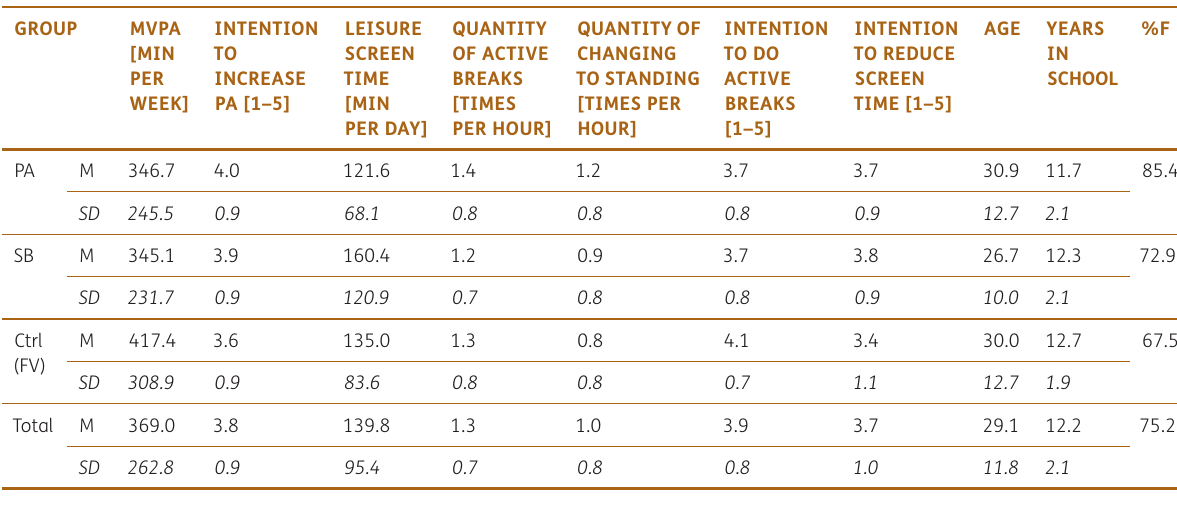
Table 1 Pre-test variable descriptives and demographics. Note: MVPA – moderate-to-vigorous physical activity; SB – sedentary behaviour; Ctrl (FV) – attention control (fruit & vegetable); %F – % Female.